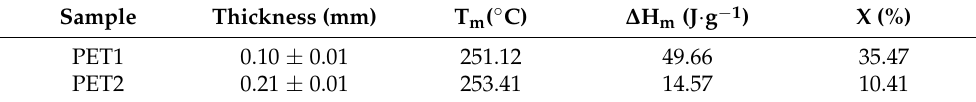
Table 2. Physical characteristics obtained using DSC analysis for the PET1 and PET2 samples.